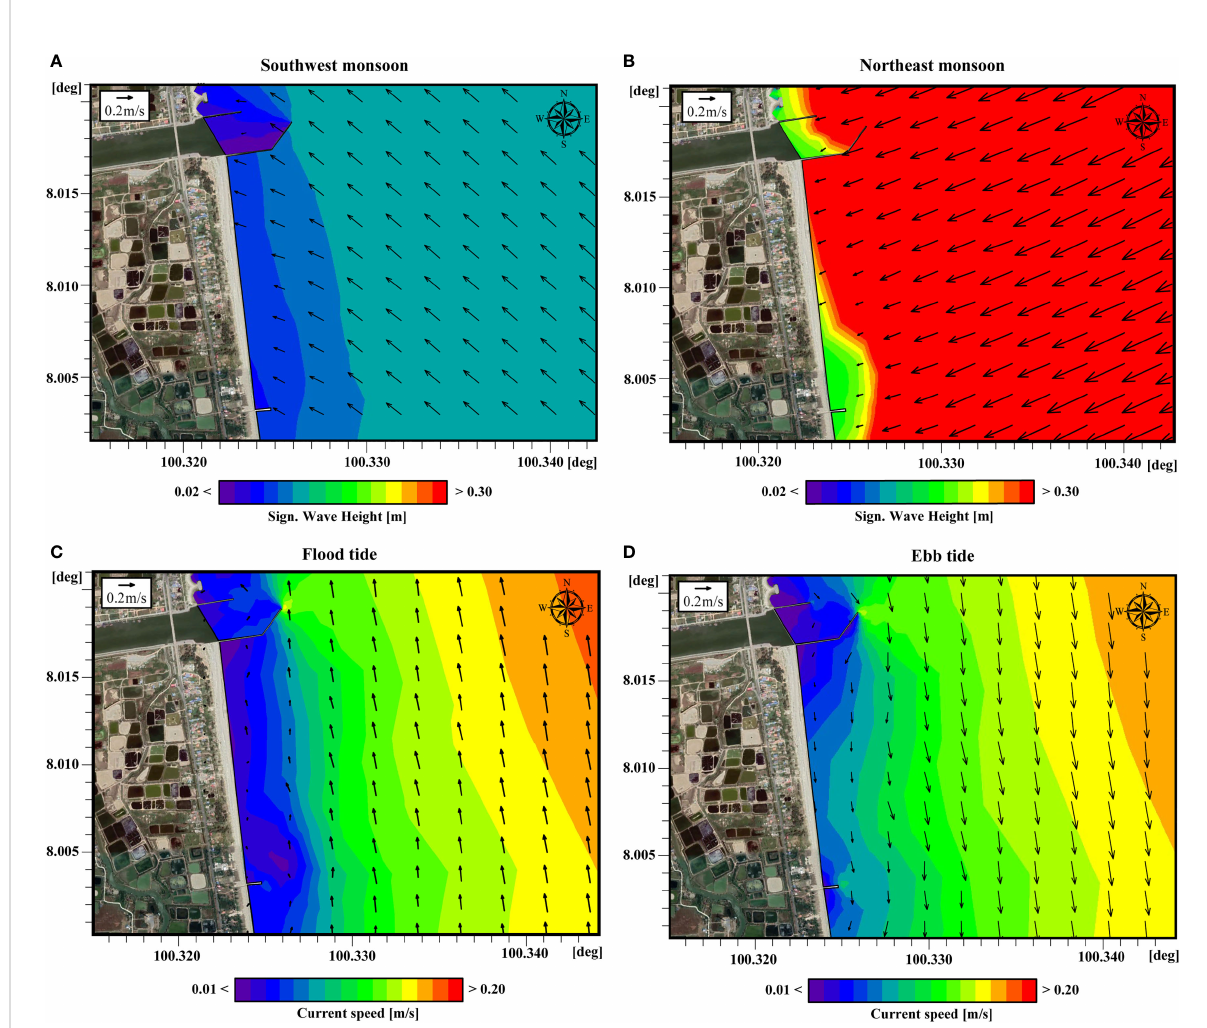
FIGURE 9 Results of MIKE 21 SW and HD at Na Saton jetty (A) signi fi cant wave height and direction (arrows) during the southwest monsoon, (B) signi fi cant wave height and direction (arrows) during the northeast monsoon, (C) current speed and direction (arrows) during fl ood tide, (D) current speed and direction (arrows) during ebb